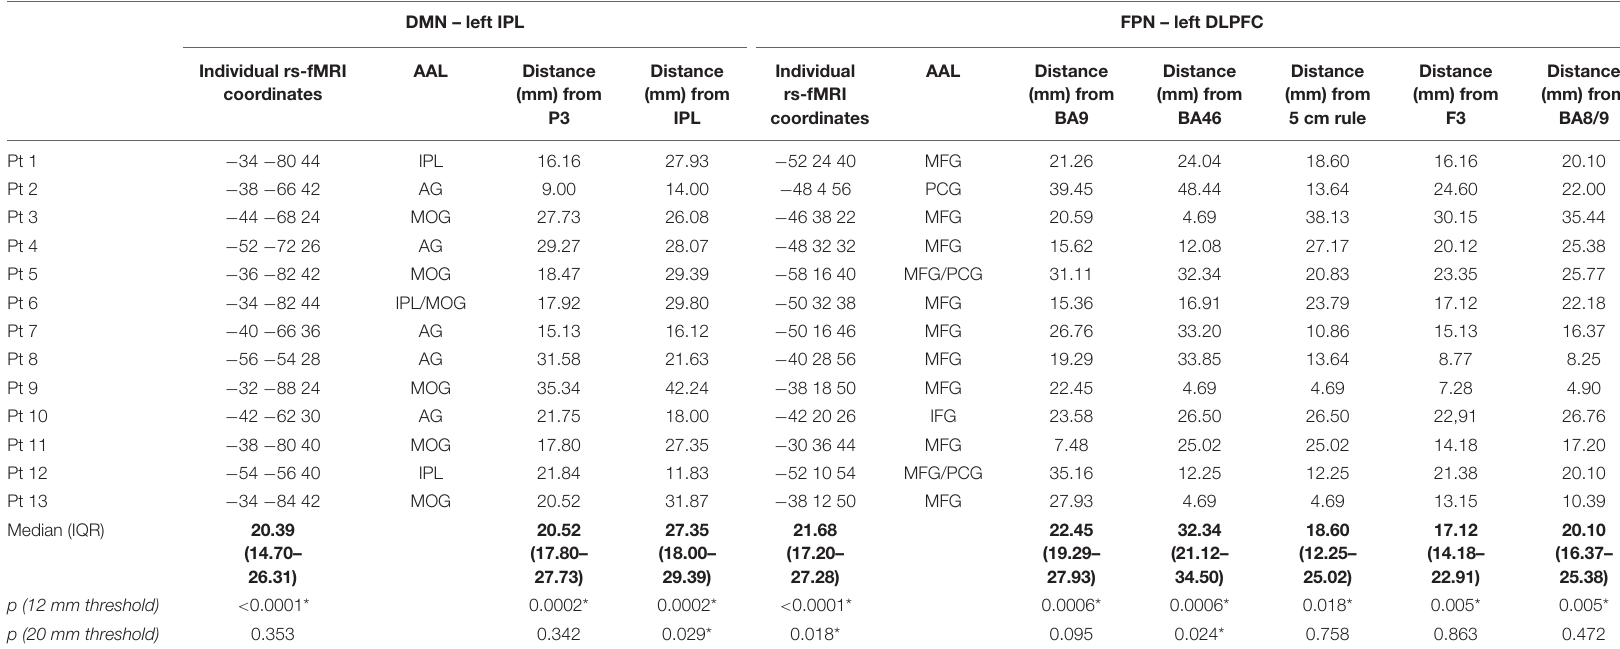
The corresponding anatomical region is provided based on the Anatomical atlas label (AAL), and the average distance between individual coordinates and group-level coordinates is provided. Results of one-sample Wilcoxon tests (p-values) assessing the null hypothesis that the distance between individual and group-level coordinates is below 12 mm and 20 mm are reported (*significant difference). DMN, default mode network; FPN, fronto-parietal network; BA8/9, Broadmann areas 8 and 9; BA9, Broadmann area 9; BA46, Broadmann area 46; IPL, inferior parietal lobule; DLPFC, dorsolateral prefrontal cortex; AG, angular gyrus; IFG, inferior frontal gyrus; MFG, middle frontal gyrus; MOG, middle occipital gyrus; PCG, precentral gyrus; IQR, interquartile range. Bold numbers depict median and IQR